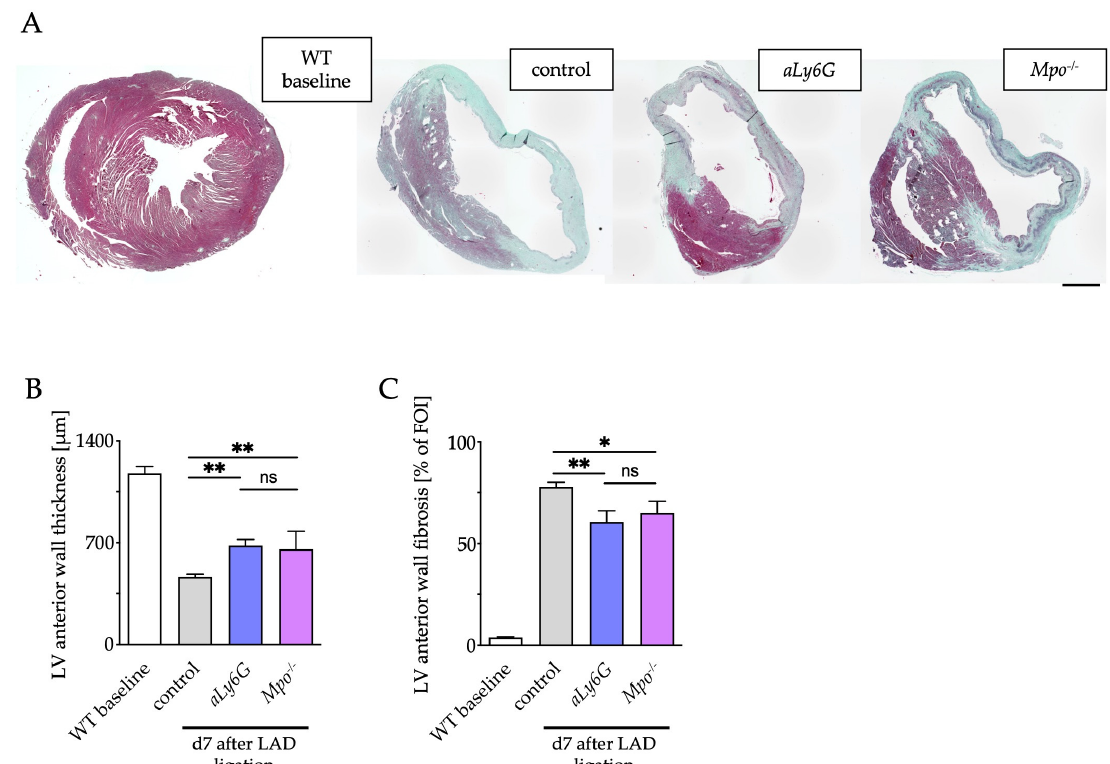
Figure 3. Structural remodeling after MI. ( A ) Representative Masson’s trichrome staining of murine hearts of WT baseline and after 7 days of PI. Scale bar: 1 mm. ( B ) Quantification of LV anterior wall thickness and ( C ) of left ventricular fibrotic areas. n = 4/8/8/8; * p < 0.05, ** p < 0.01, ns = not significant; one way ANOVA test followed by appropriate post hoc test, mean ± SEM is